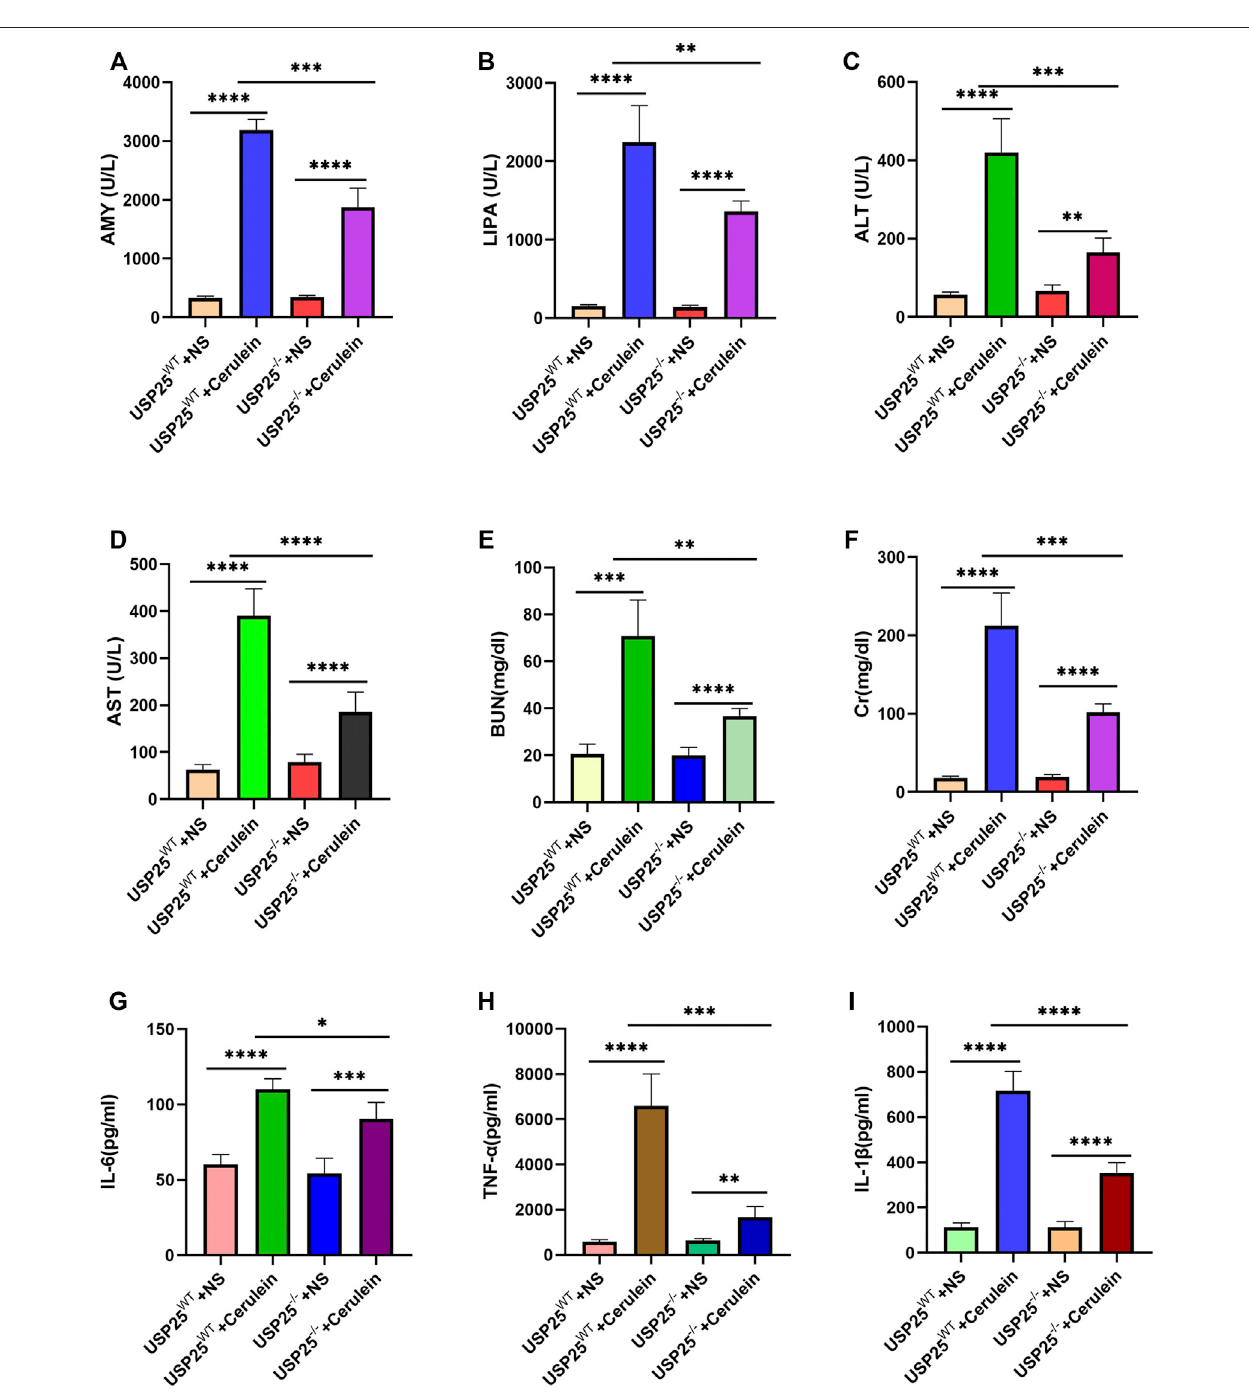
FIGURE4| USP25de fi ciencyreducesmice serum indicators levels ofacute pancreatitis and relieves acute pancreatitis-related multiple organ failure in vivo . (A – F) MiceserumAMY,LIPA,ALT,AST,Cr,BUN,CRPwereexaminedbyautomaticchemicalanalyzerinfourexperimentalgroups(n (cid:1) 8pergroup),includingUSP25 WT +NS, USP25 WT + cerulein, USP25 − / − + NS, USP25 − / − + cerulein. (G – I) The levels of serum IL-6, TNF- α , and IL-1 β in USP25 WT + NS, USP25 WT + cerulein, USP25 − / − + NS, USP25 − / − + cerulein mice were measured by ELISA (n (cid:1) 8 per group). * p < 0.05, ** p < 0.01, *** p < 0.001 and **** p < 0.0001.